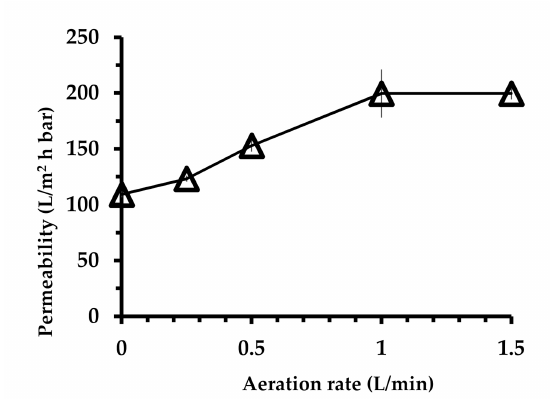
Figure 3. E ff ect of aeration rate on steady-state permeability at a constant 15 ◦ tilting